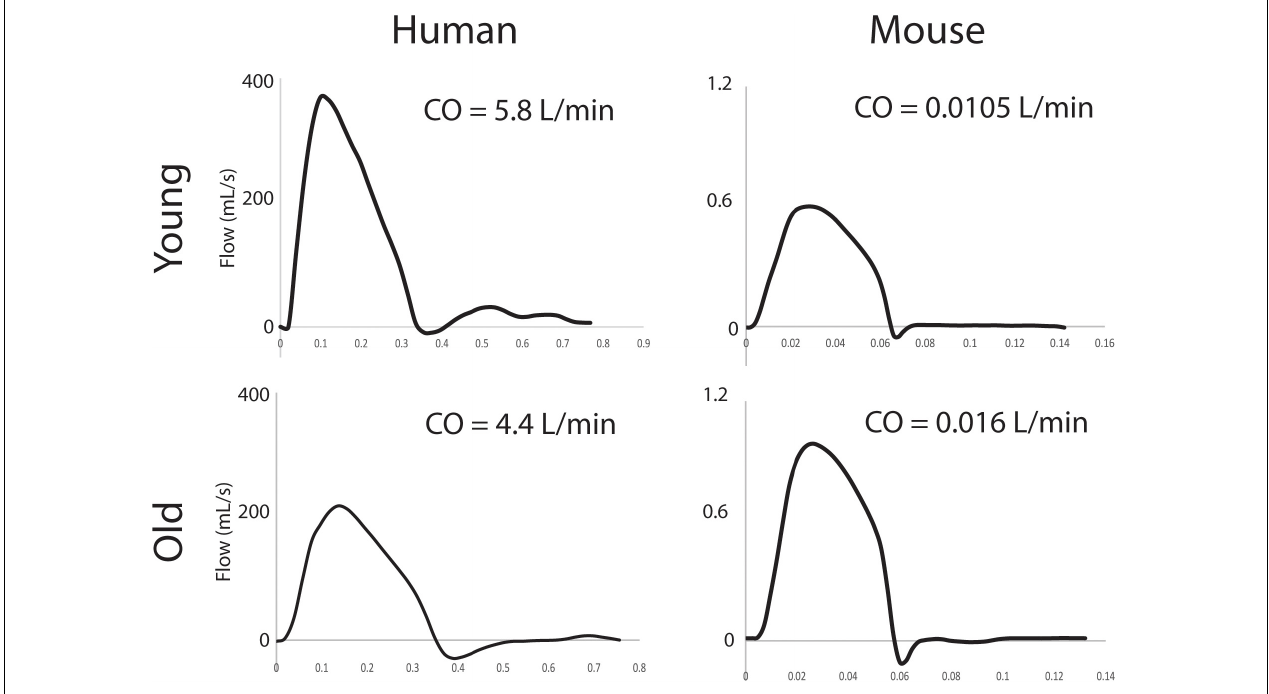
FIGURE 2 | ATA inflow waveforms (mL/s) and associated values of CO (L/min).